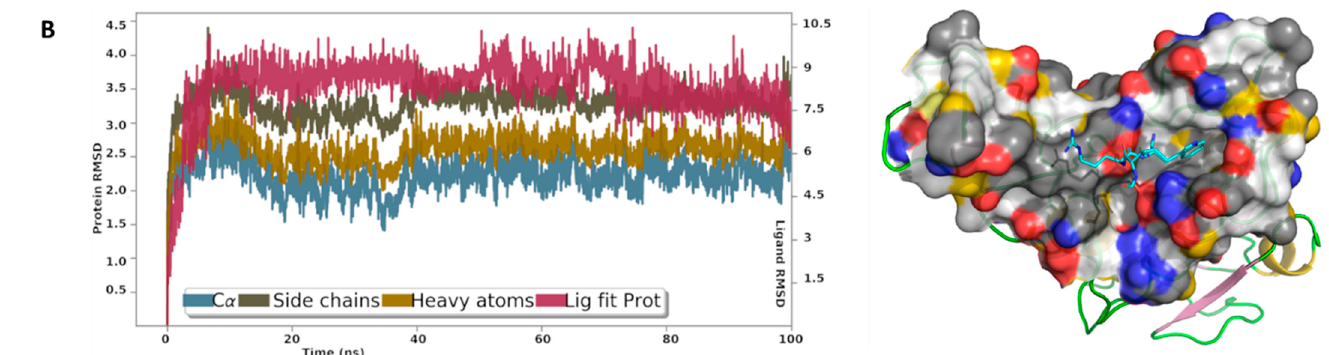
Figure 8. The root mean square deviation curves of A9 and A14 complexes with the RBD. The initial system is displayed on the left showing ( A ) A9 and ( B ) A14 in the binding site of the RBD. YRB scheme was used to highlight the hydrophobic regions. The plot shows the RMSD of the Ca, side chains, and heavy atoms of the RBD. ‘Lig fit Prot’ displays the RMSD of a ligand after aligning the protein-ligand complex on the protein backbone of the initial configuration and measuring the RMSD of the ligand-heavy atoms.